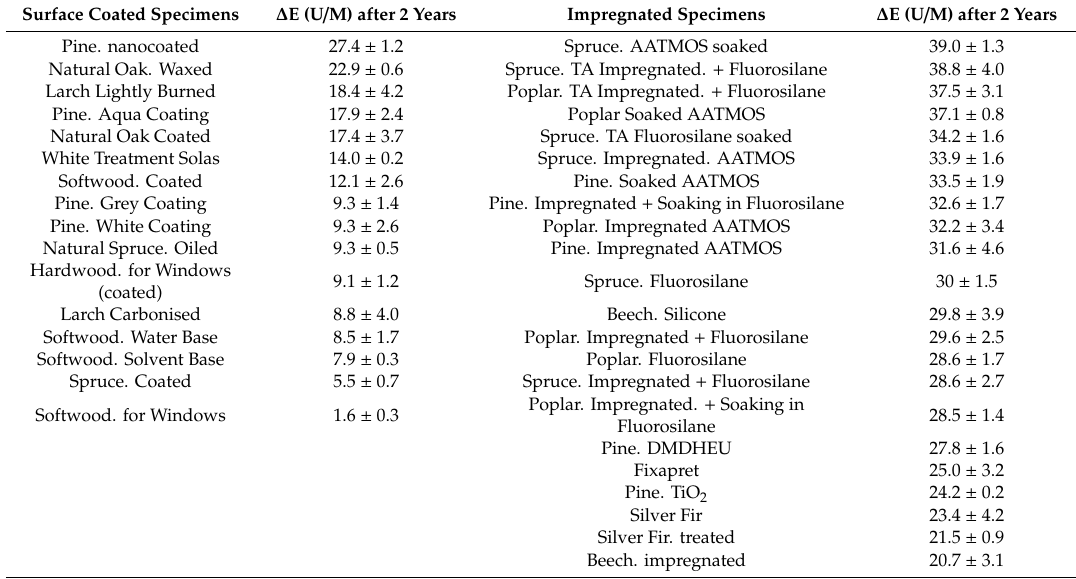
Table 3. Colour change of surface coated and impregnated wood-based